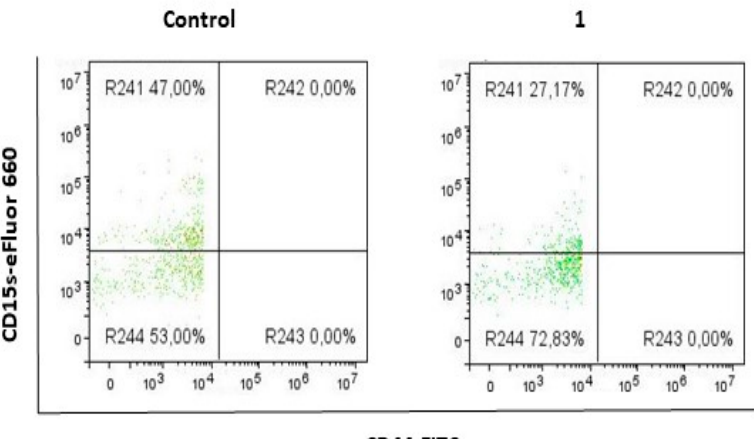
Table 1. Percentage and events of CD15s in CSC after treatment with compound 1.